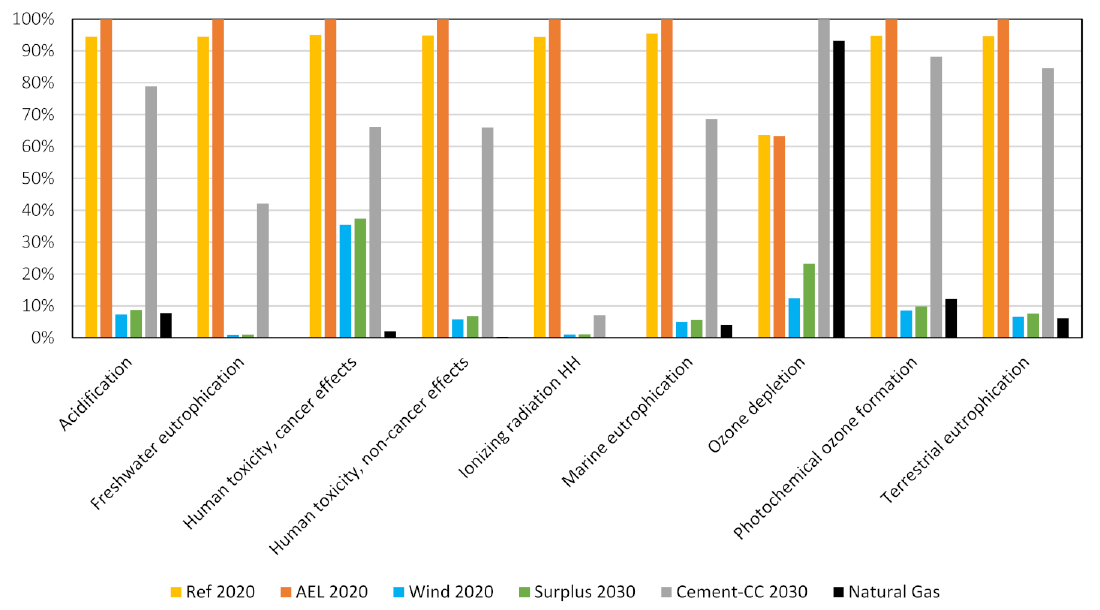
Figure 10. Life cycle impact assessment (cradle-to-gate) of all scenarios in comparison to natural gas. The values are relative to the highest impact of a scenario for each impact category.